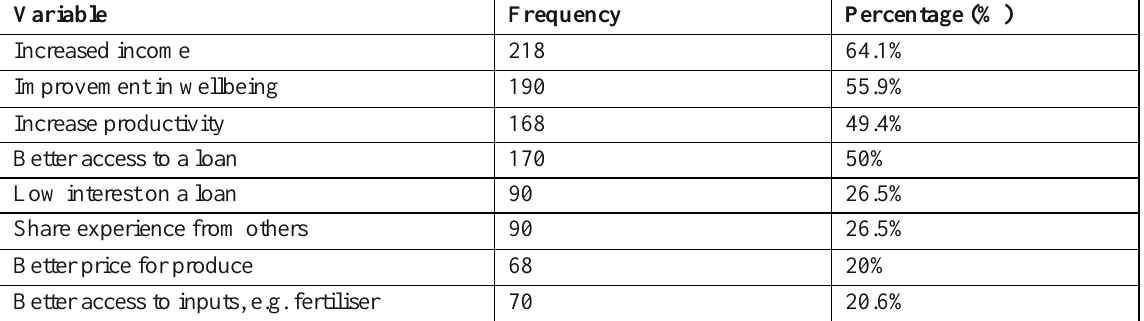
Table 4: Respondents' Perception on Benefits Derived from Membership of RUDEP Cooperative